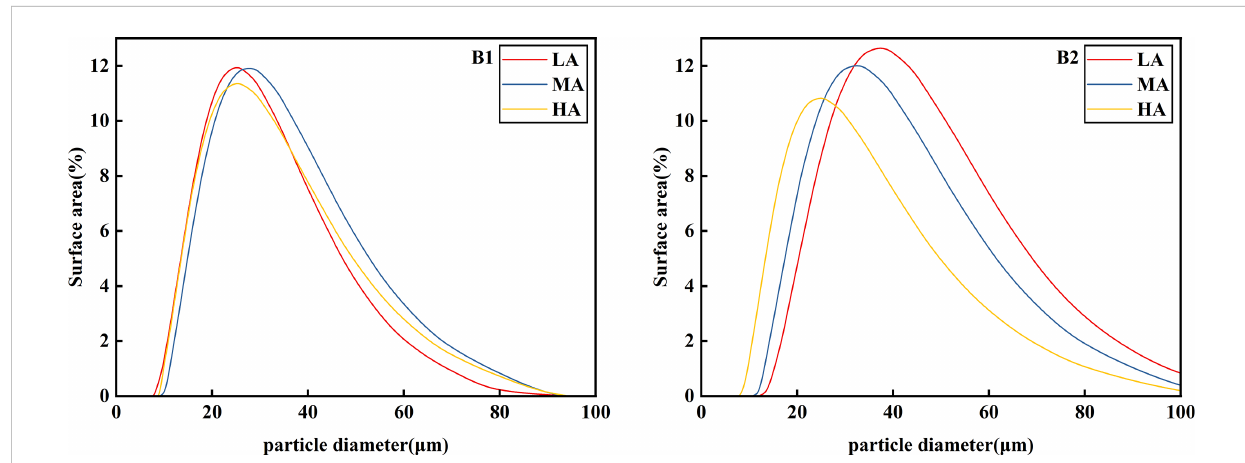
FIGURE 5 Surface area distribution of potato starch granules at different altitudes. LA (low altitude), MA (middle altitude) and HA (high altitude) stand for Chongzhou, Xichang and Litang respectively; B1 and B2 stand for Jiusen No. 1 and Qingshu No. 9